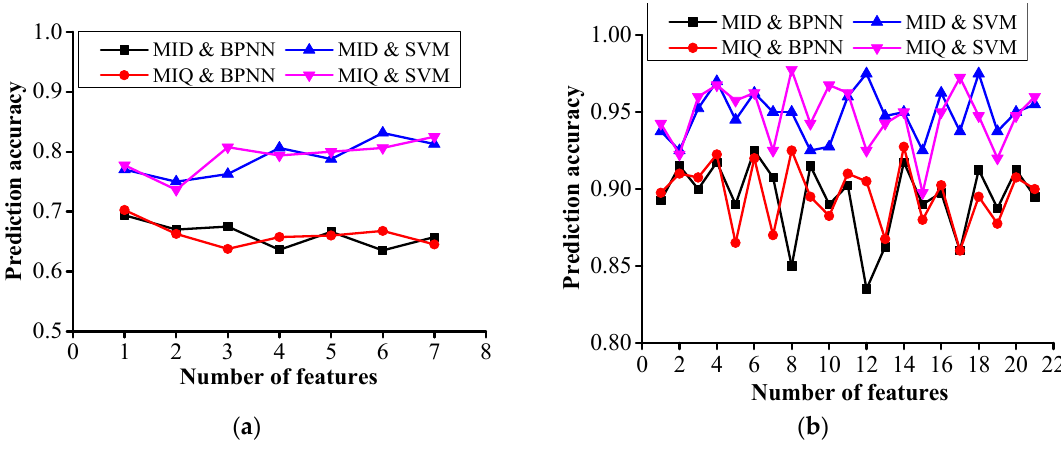
Figure 11. Predication accuracy over the number of features: ( a ) concentration feature; and ( b ) concentration ratio feature.